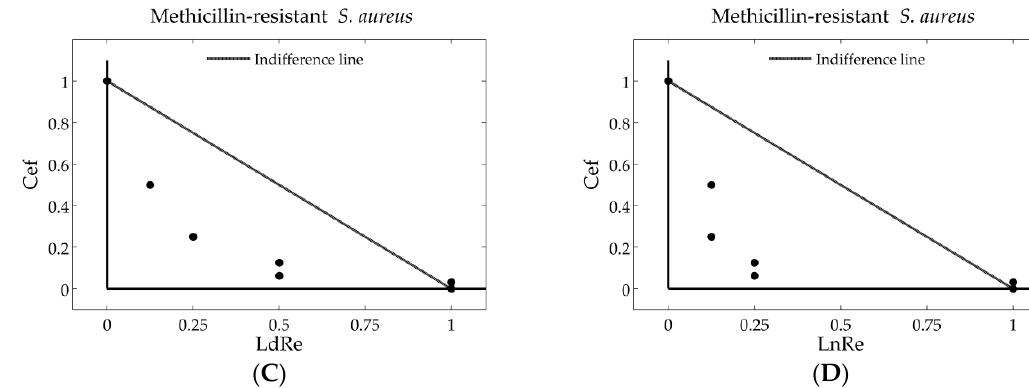
Figure 4. Normalized Isobolograms of LdRe or LnRe with cefotaxime against Methicillin-sensitive Staphylococcus aureus ATCC 25923 (MSSA) ( A , B ) and normalized Isobolograms of LdRe or LnRe with cefotaxime against Methicilin- resistant S. aureus ATCC 43300 (MRSA), respectively ( C , D ). The discontinuous line represents the indifference line and the points the experimental combinations at different levels.